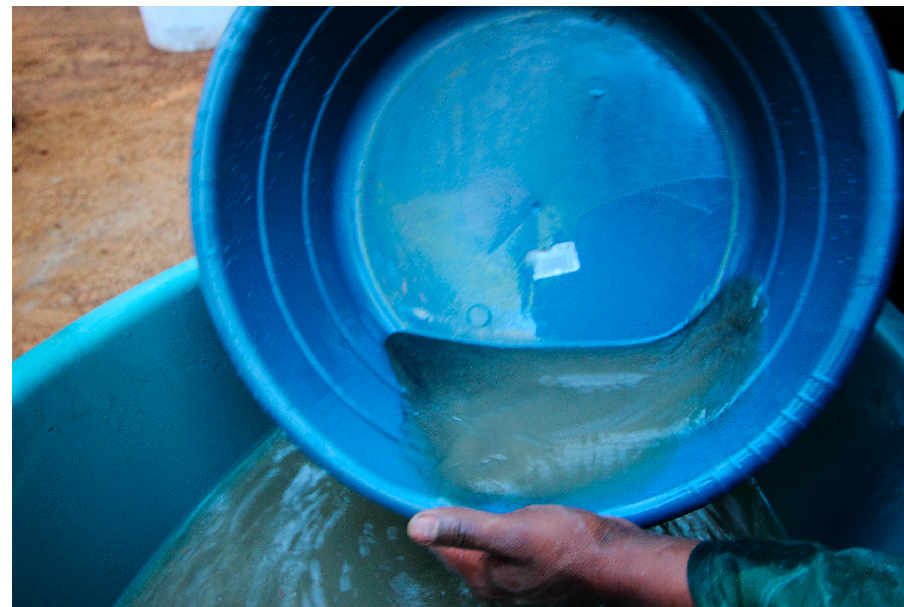
Figure 6. The ‘fast-washing’ process: small amounts of running water are used to wash off the light density material and fines. This process has also been recorded by a covert camera on one of the operations. Geosciences 2018 , 8 , x FOR PEER REVIEW